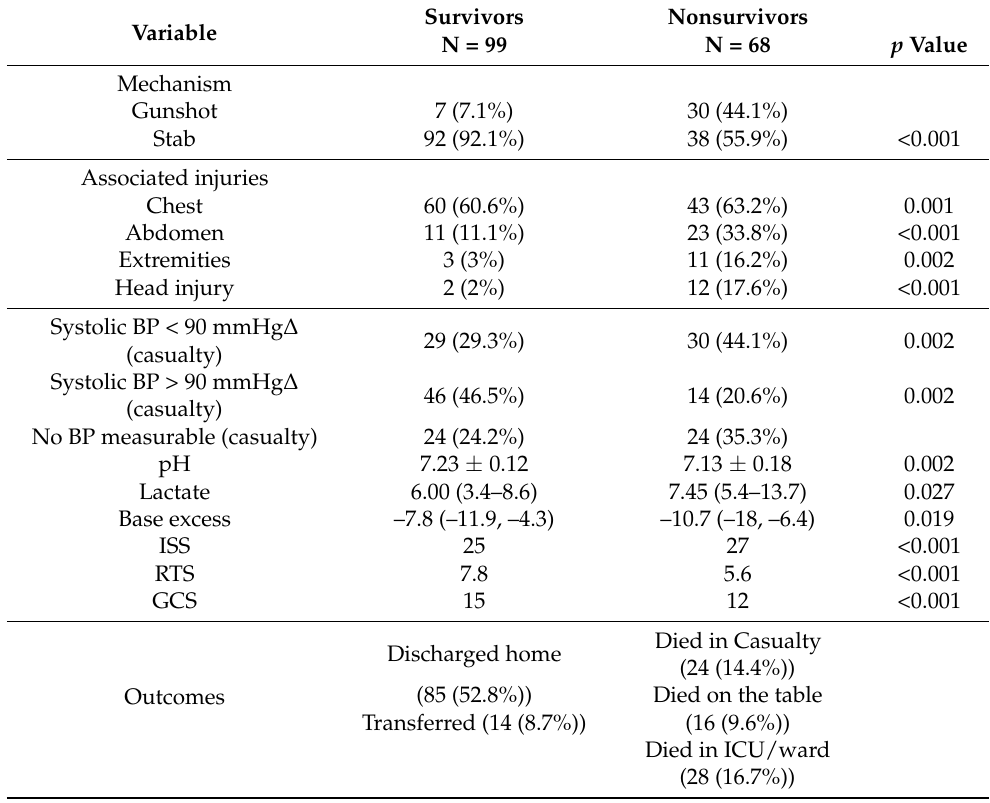
Table 5. Mortality outcome’s